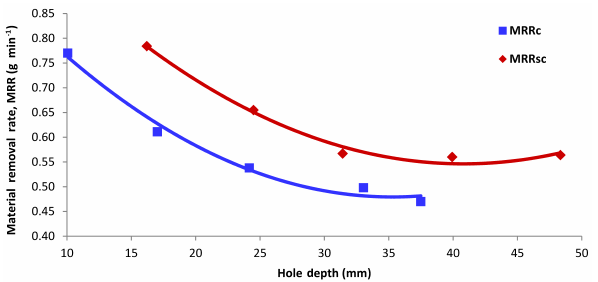
Figure 11. Results of OC with respect to hole depth.